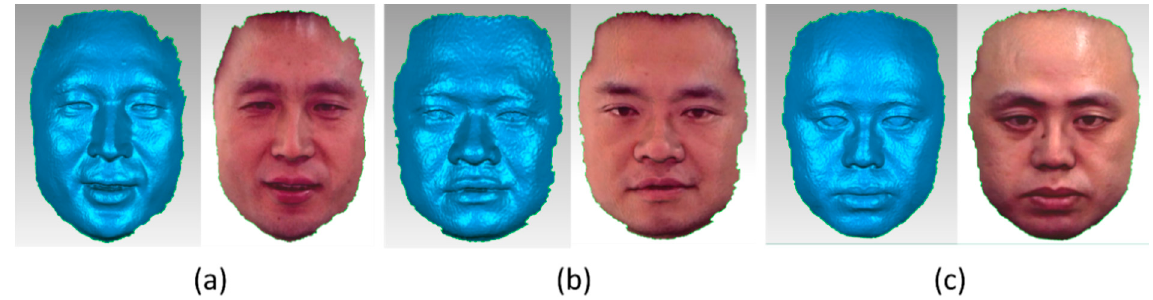
Figure 14. ( a1 − a3 ) Three-dimensional (3D) reconstruction results of (N = 3, 6, 12) different speckle stereo image pairs. ( b1 − b3 ) Corresponding comparison maps with 3D scanned data by ATOS Core 300.